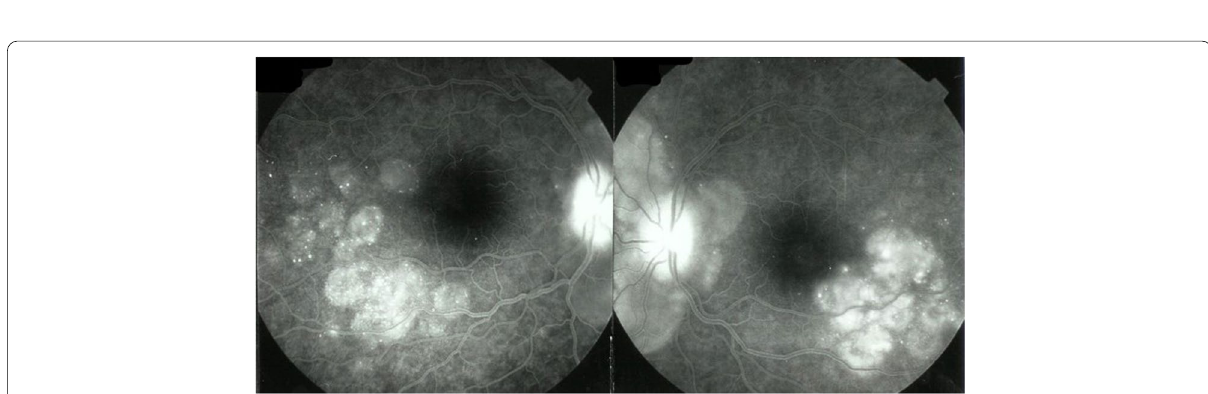
Fig. 4 Fluorescein angiogram findings in acute phase VKH. Hyperfluorescent pinpoints and pooling mark the exudative retinal detachments. Note the bright hyperfluorescent